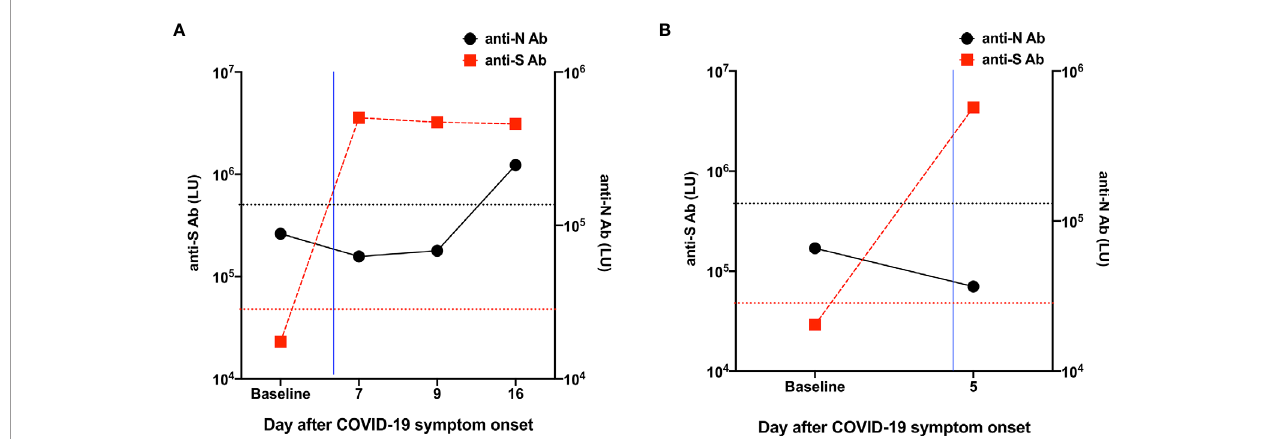
FIGURE 3 | Measurement of anti-S and anti-N antibodies against SARS-CoV-2 in the patients included in our study. (A) The baseline value was obtained from a stored serum sample from the Patient 1 initial NIH visit in 2017. The blue line corresponds to the day when the patient received bamlanivimab and etesevimab. These fi ndings demonstrate that the patient mounted a natural immune response to the nucleocapsid of SARS-CoV-2 despite the administration of bamlanivimab and etesevimab. (B) The baseline value was obtained from a stored serum sample from the Patient 2 initial NIH visit in 2017. The blue line corresponds to the day after the patient received bamlanivimab and etesevimab. Horizontal dotted red and black lines indicate cut-off thresholds of positivity for anti-S and anti-N antibodies, respectively, and were based on the mean plus 3 and 4 standard deviations (SDs), respectively, of the serum values derived from 32 uninfected blood donor